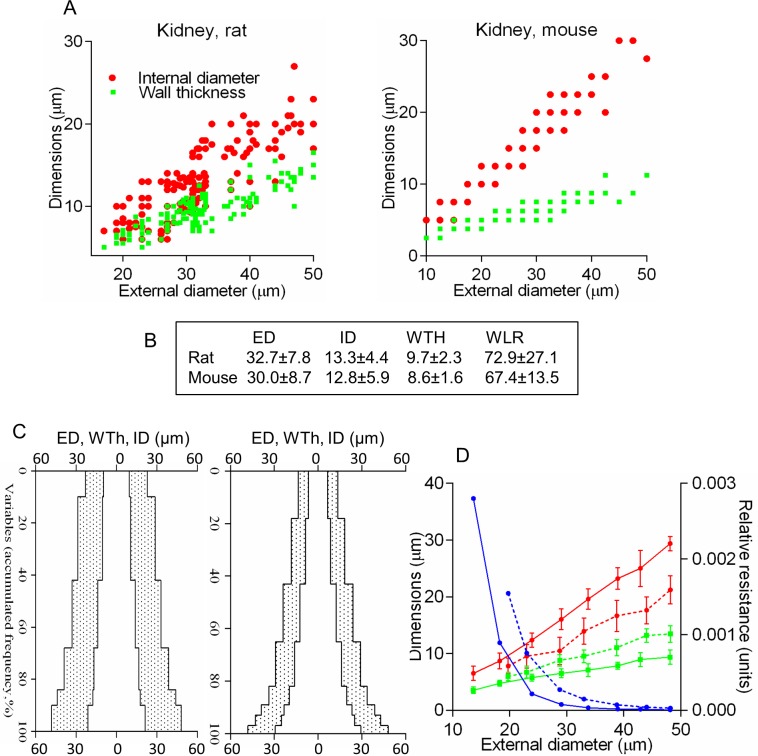
The algorithm enables comparison between species.(A) Scatterplots for the external diameter (ED), internal diameter (ID), and wall thickness (WTh) for the rat and mouse. (B) Mean values from scatterplots revealed no difference (P>0.40), including wall-to-lumen ratio (WLR). The corresponding complex profiles (C), and regression equations with the relative resistance curves (D) were very distinctive (P<0.001) for the rat (dashed line) vs mouse (solid line).